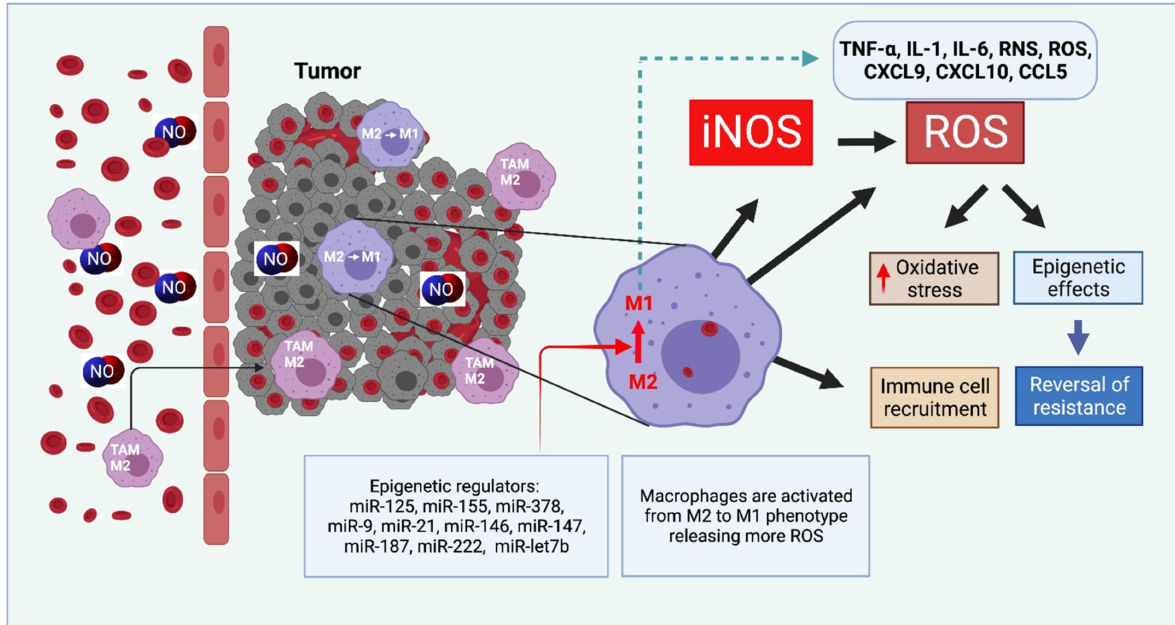
Figure 5. Exogenous NO or iNOS-derived NO modulate the macrophage status. M2-type macrophages may be re-polarized into M1 phenotype via regulatory miRNA. ROS-generated oxidative stress may produce a cytocidal profile and reverse tumor